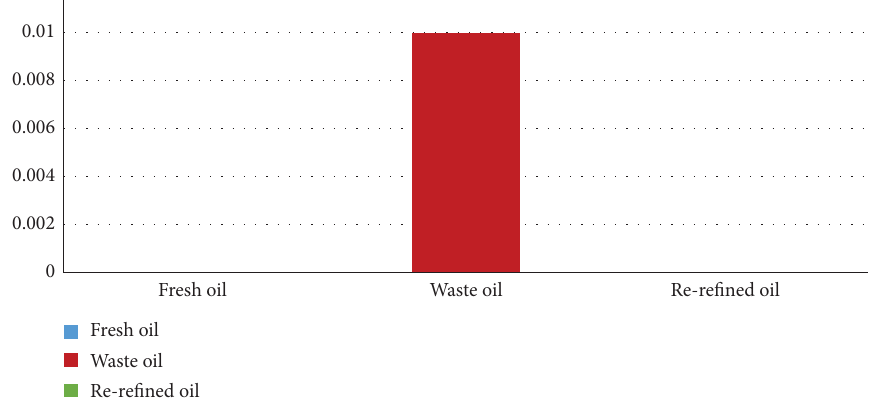
Figure 8: Water content in the oil samples.